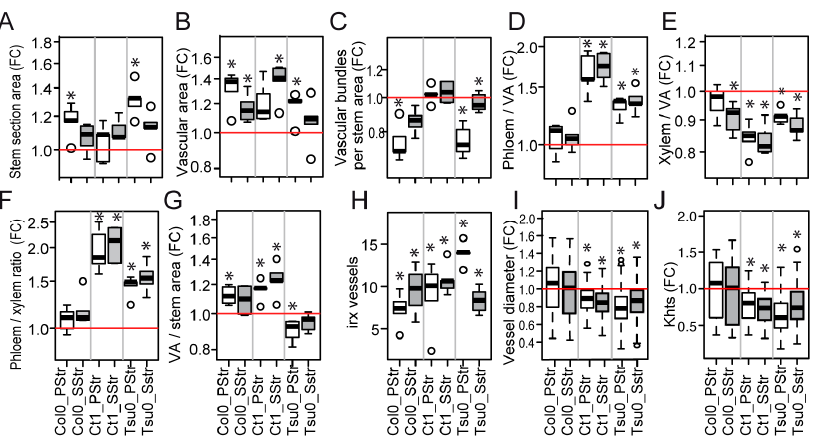
Figure 8. Natural variation in the Arabidopsis stem anatomy in response to a high salinity at 17 DAB. ( A – I ) The box and whisker plots represent the distribution of the biological replicates (see Figure 2 for details), within the ( A ) fold changes in the stem section areas, ( B ) the fold changes in the total vascular areas per stem section (VA), ( C ) the fold changes in the number of vascular poles per stem section surface unit, ( D ) the fold changes in the total phloem area/VA ratio per stem section, ( E ) the fold changes in the total xylem area/VA ratio per stem section, ( G ) the fold changes in the phloem area-to-xylem-area ratio, ( G ) the fold changes in the VA per surface unit of the stem section, ( H ) the number of irregular xylem (irx) vessels per vascular bundle, ( I ) the fold changes in the xylem vessel lumen area ( J ), and the fold changes in theoretical hydraulic specific conductivity. In grey—SStr plants. In white—PStr plants. FC—fold changes. Stars denote significant differences of salt treatment compared to the control condition (* p < 0.05, n = 4–6, except for the irx vessels and Khts values, with n > 36).